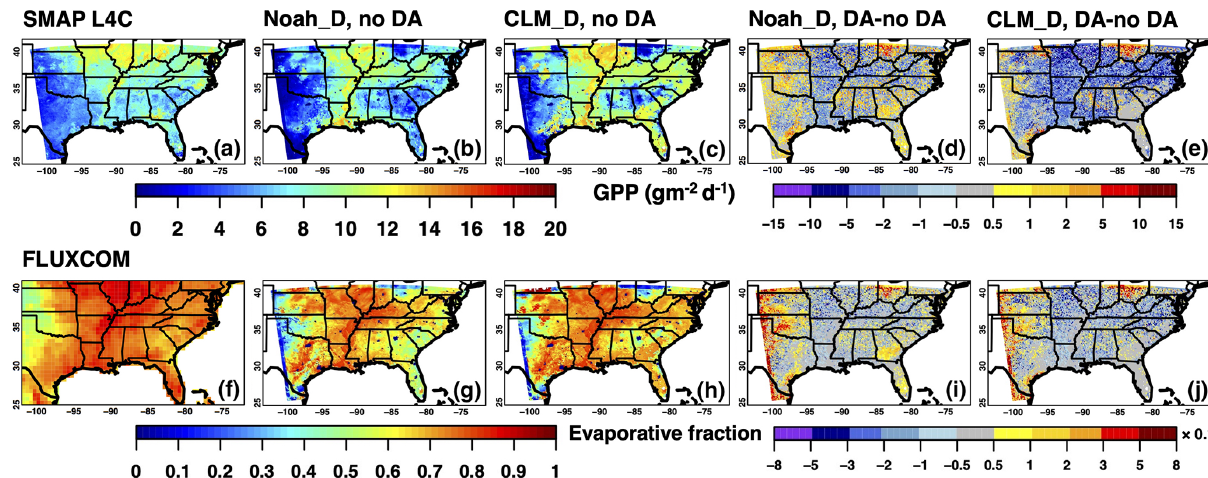
Figure 4. Period-mean (16–28 August 2016) WRF-Chem calculated (b–e) gross primary productivity (GPP) and (g–j) evaporative fraction as well as their responses to the SMAP DA. Results based on the Noah_D and CLM_D cases are shown in (b) , (d) , (g) , and (i) and (c) , (e) , (h) , and (j) , respectively. Period-mean SMAP L4C GPP and FLUXCOM evaporative fractions are shown in (a) and (f) , respectively, which are also used to evaluate the model results (Table